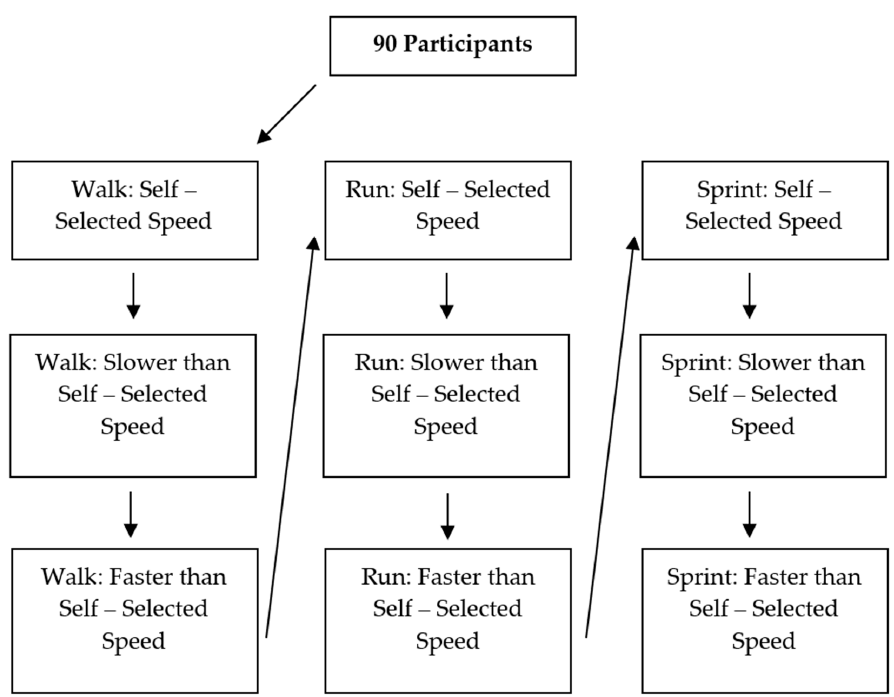
Figure 1. The setup included eight motion capture cameras surrounding the ten-meter-long running lane. The LPS hub was placed on a tripod, 2 m behind the starting position.